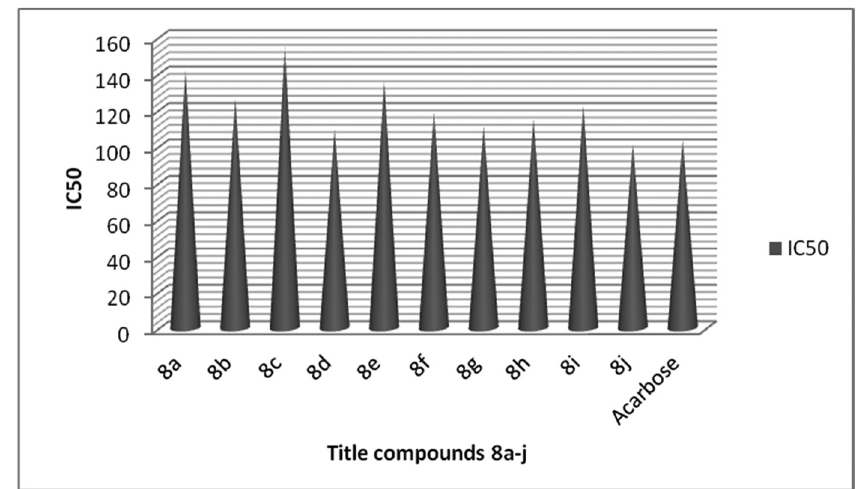
Figure 2: IC 50 values of compounds 8a – j